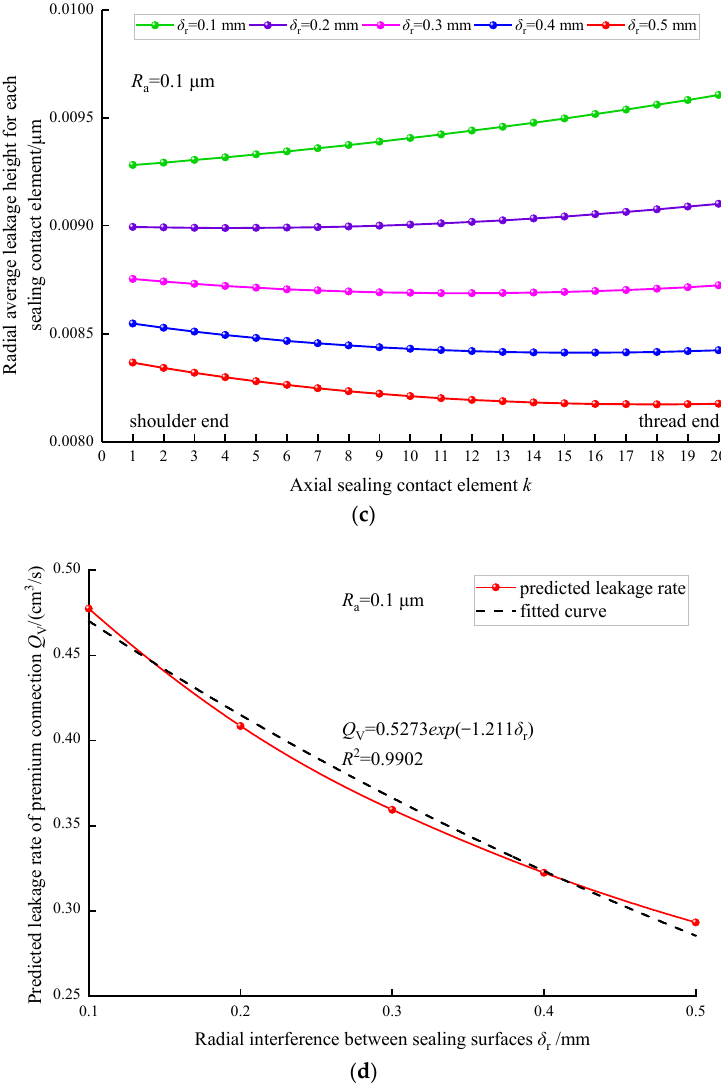
Figure 8. Predicted sealing parameters of each axial sealing contact unit and leakage rate for cone-to-cone-type premium connection for different amounts of radial interference between sealing surfaces. ( a ) Average contact pressure for each sealing contact element. ( b ) Total circumferential leak- age width for each sealing contact element. ( c ) Radial average leakage height for each sealing contact element. ( d ) Predicted leakage rate of premium connection.